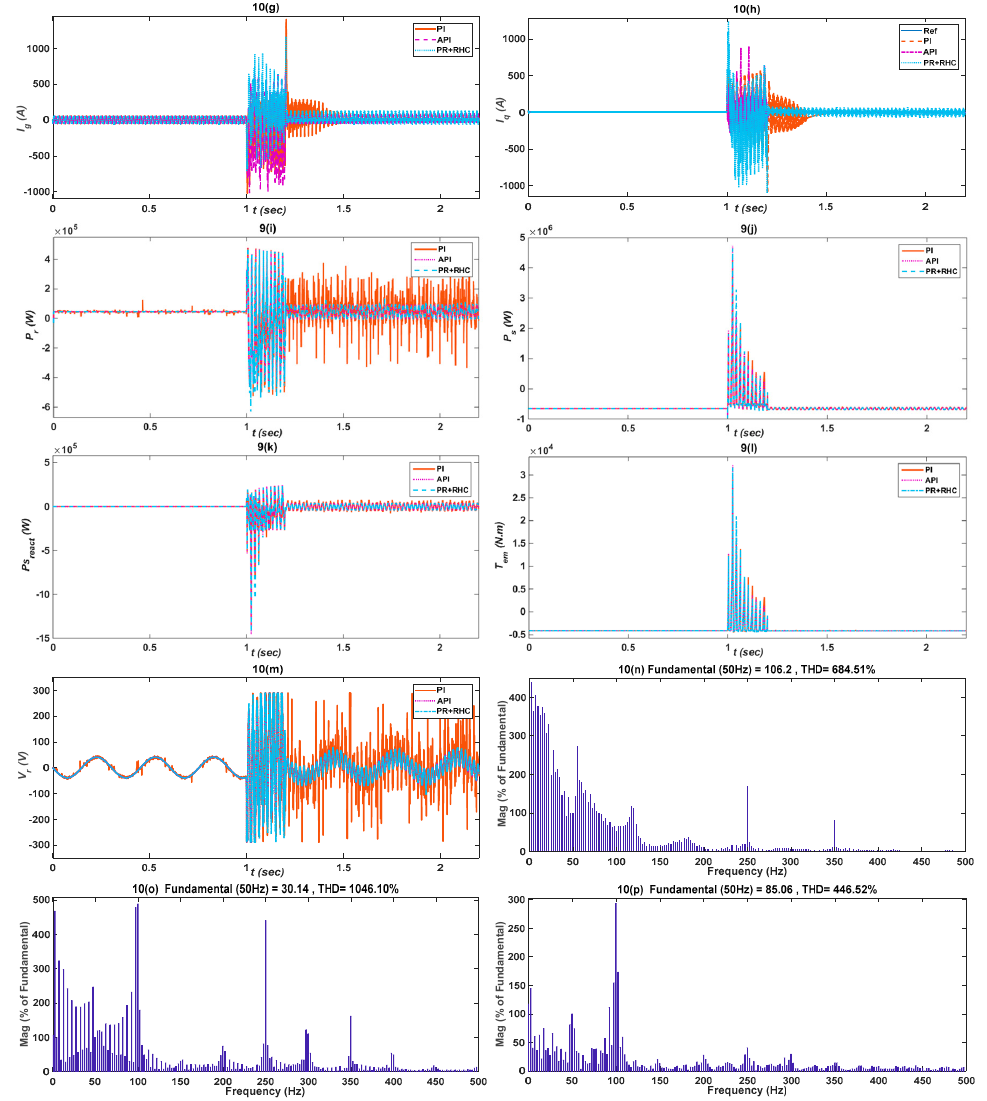
Figure 10. Comparison of PI and Proposed API and PR+RHC controller responses under overvoltage fault, considering: ( a ) Dc-link voltage V dc ; ( b ) Stator voltage V s ; ( c – e ) Active component of current I d ; ( f ) Rotor current I r ; ( g ) Reactive current component I q ; ( h ) Grid current I g ; ( i ) Rotor active power P r ; ( j ) Stator active power P s ; ( k ) Electromagnetic torque T em ; ( l ) Stator reactive power Ps react ; ( m ) Rotor voltage V r ; ( n ) PR+RHC controller THD; ( o ) PI controller THD; ( p ) API controller. Table 8. Performance evaluation of the designed control strategies for V dc . Control Strategies